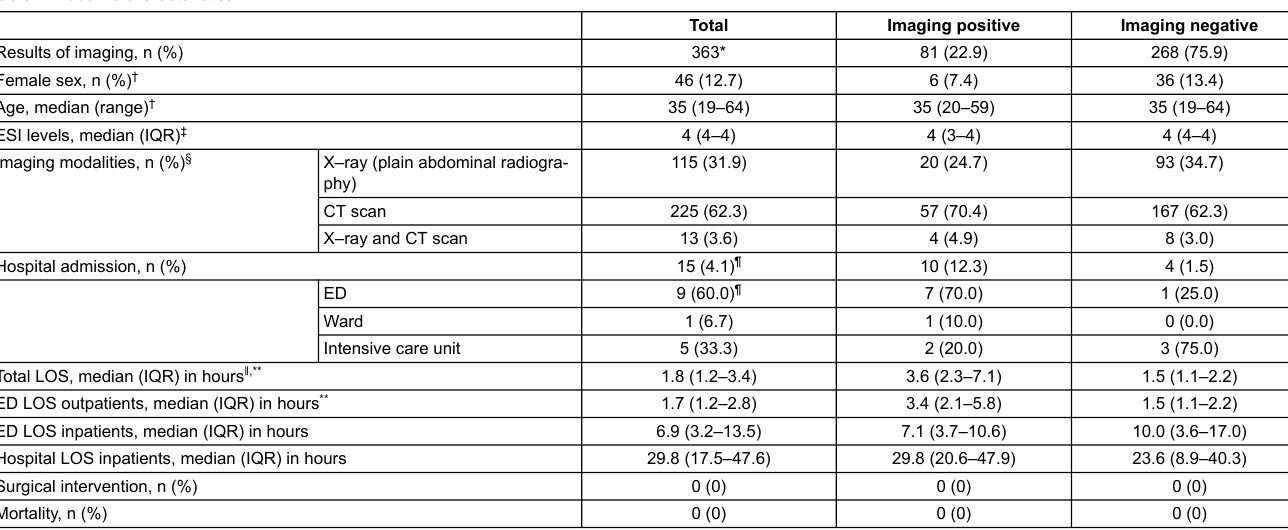
Total Imaging positive Imaging negative